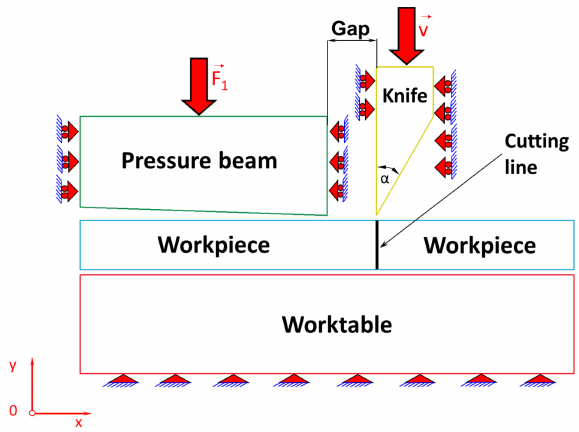
Figure 1. Physical model of a cutting process.